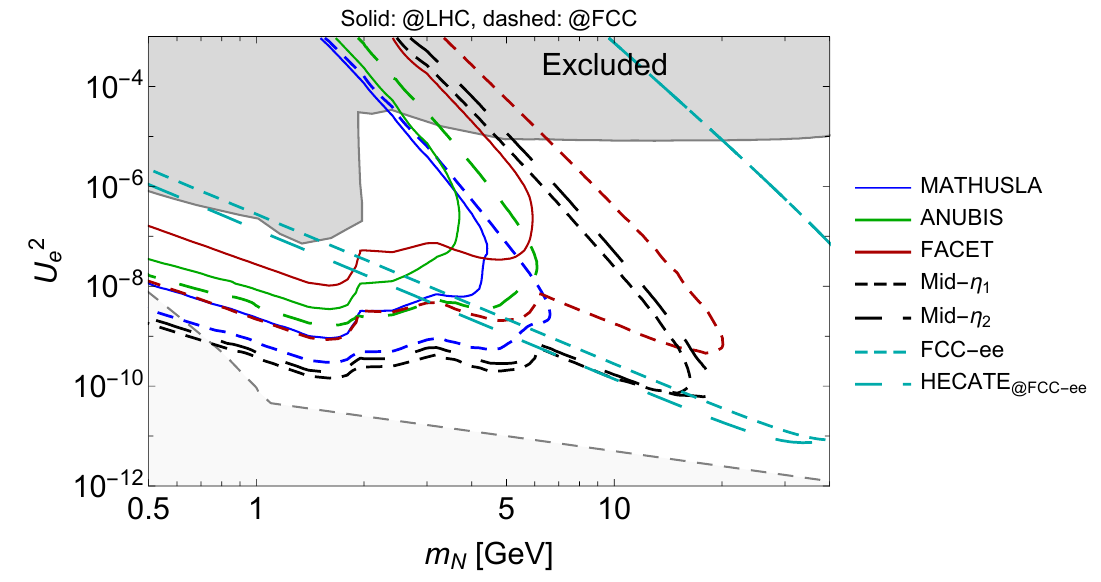
Figure 8 . The sensitivity of various LHC-based experiments and experiments at FCC-hh proposed in this paper. For the case of the LHC experiments, we show MATHUSLA, ANUBIS, and (for the first time) FACET, indicated by solid lines; note that the sensitivity of ANUBIS we obtained is significantly weaker than reported in [30], see text for details. For the case of the FCC-hh experiments, we show the sensitivities of counterparts of ANUBIS, FACET, and MATHUSLA experiments, as well as the reach of novel proposals — the mid- η experiments, covering | η | < 2 . 6 (see section 3). We also show the sensitivity of FCC-ee and HECATE@FCC-ee, using their setup from [2]. All the curves of the LHC-based and FCC-based experiments are obtained under the assumption of zero background (see section 4.2) and at 95%